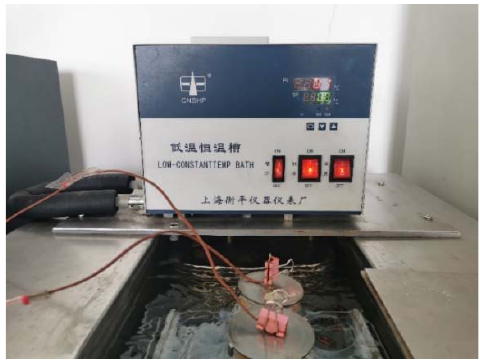
Figure 9. Actual sample of constant temperature alcohol bath cooling.